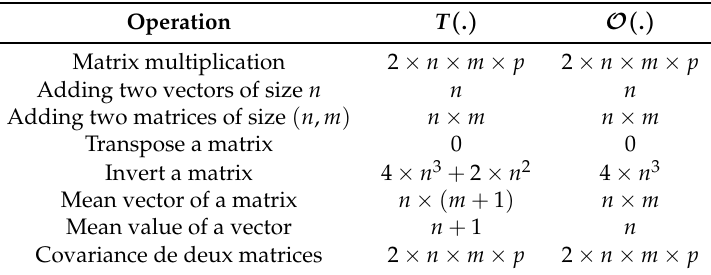
Table 3. Matrix operations complexity sum-up.